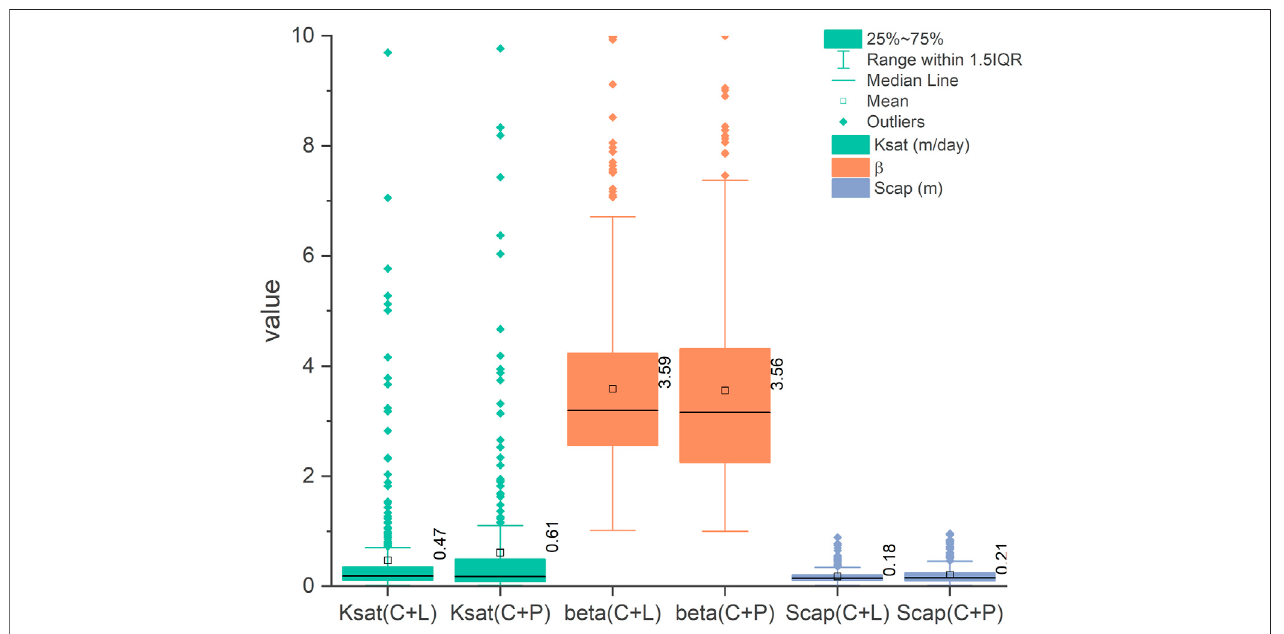
FIGURE 12 | Box plot of the calibrated parameters of the